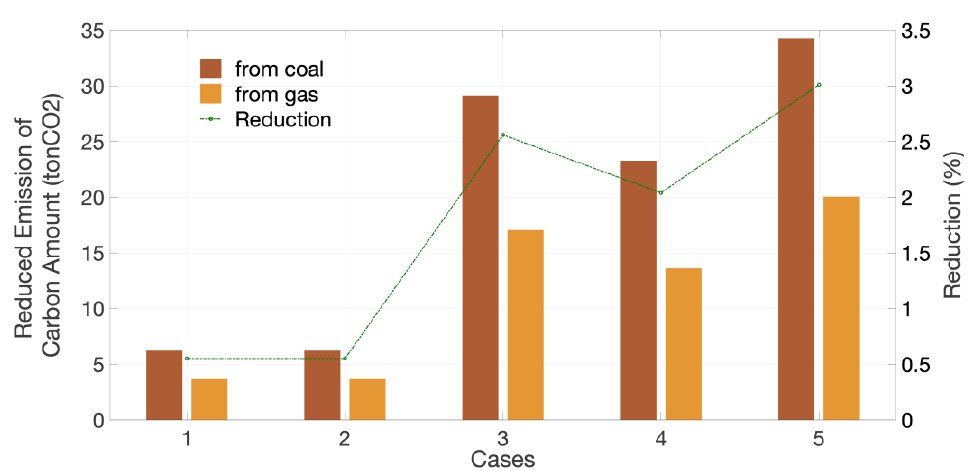
Figure 8. CO2 potential reduction from V2G substituting both coal- and gas-fueled power generators during peak hours.